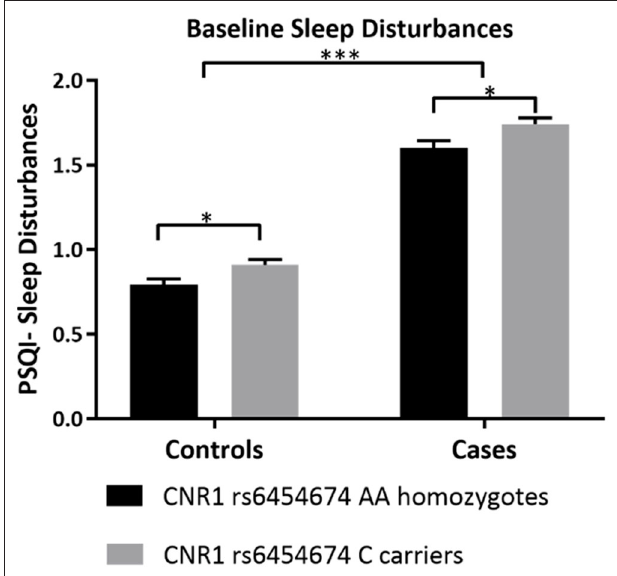
FIGURE 2 | Differences in sleep disturbances by CNR1 rs6454674 Genotype at Baseline. This figure demonstrates that, at baseline, C allele carriers (CC/AC genotypes) of CNR1 rs6454674 had greater sleep disturbances compared to AA homozygotes. The results are from the two-way ANCOVA tests run for genotype*AUD status (AUD/No AUD) after controlling for age, sex, years of education, pack years, Alcohol Dependence Severity (ADS) scores, Ancestry-informative marker (AIM scores for Africa, Europe), presence of mood disorders, and/or anxiety disorders, presence of Cannabis Use Disorder, and/or any Substance Use Disorder other than nicotine (controls: [ F (1,344) = 5.832, p = 0.016, partial η 2 = 0.017], N = 357 and AUD: [ F (1,443) = 6.017, p = 0.015, partial η 2 = 0.013, N = 456]. Bars represent adjusted means and error bars denote standard errors. Higher scores indicate poorer sleep quality in PSQI. PSQI, Pittsburgh Sleep Quality Index. * p < 0.05, *** p <